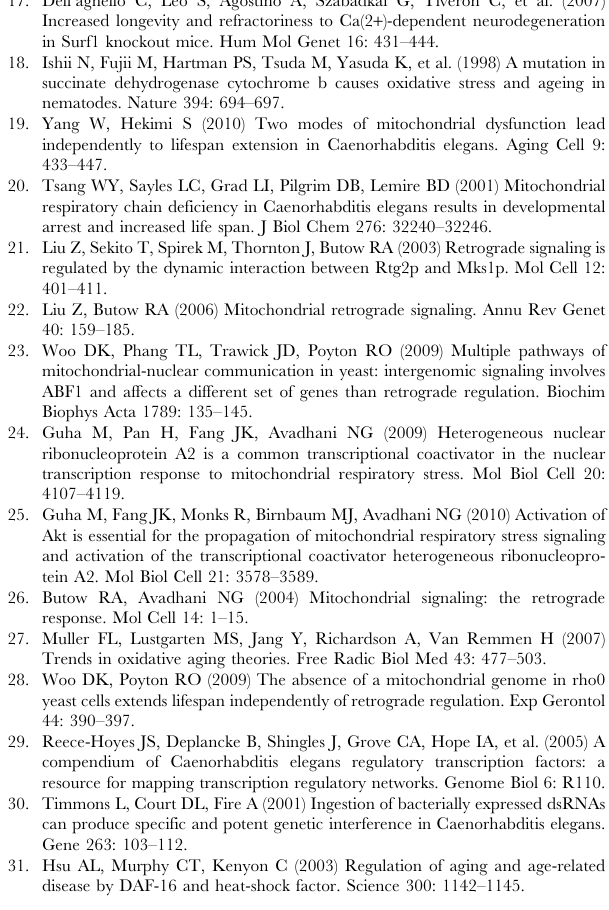
Figure S6 The transgene overexpressing ceh-23 is functional. (A)